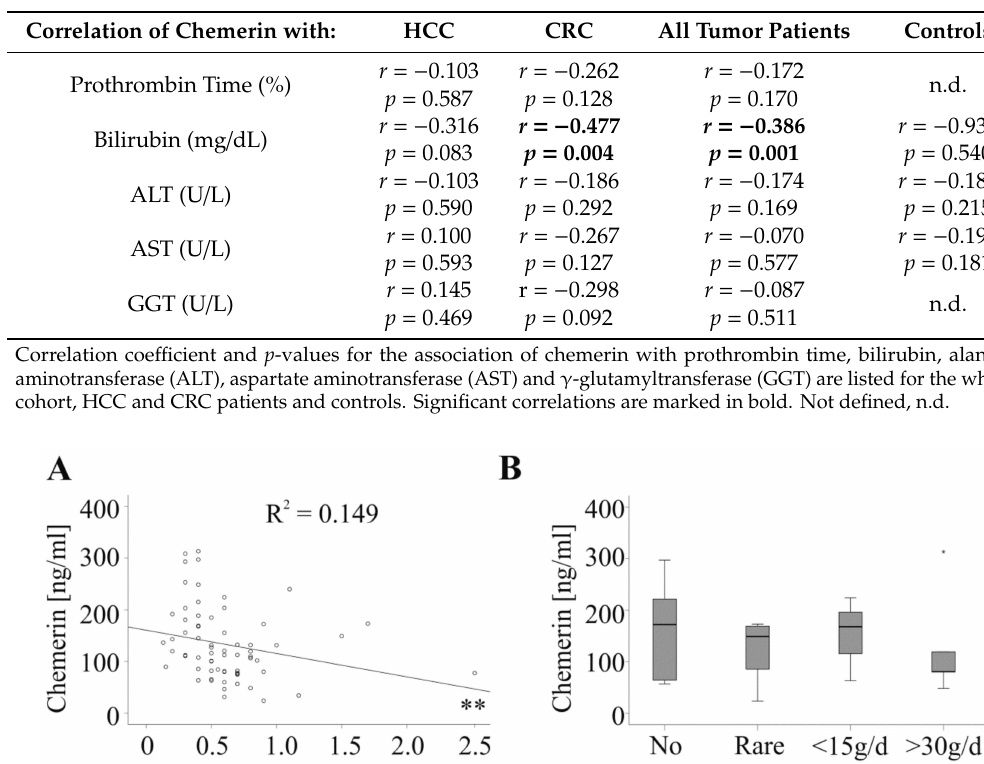
Table 2. Correlation of serum chemerin with markers of liver function.